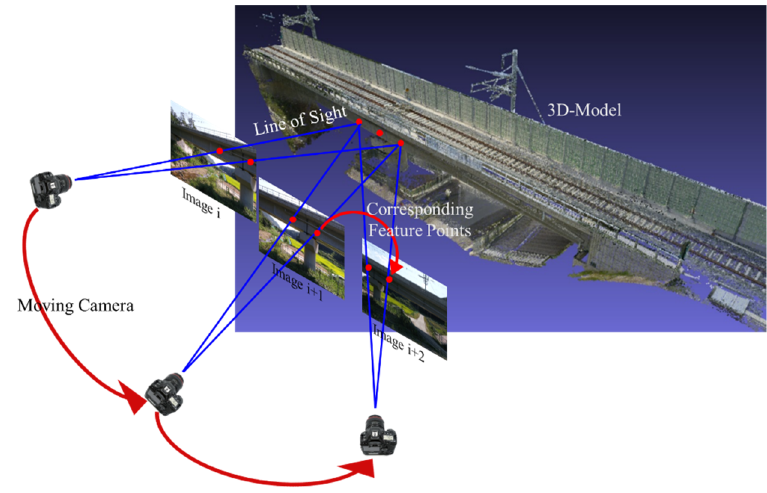
Figure 11. Principle of the SfM photogrammetry.